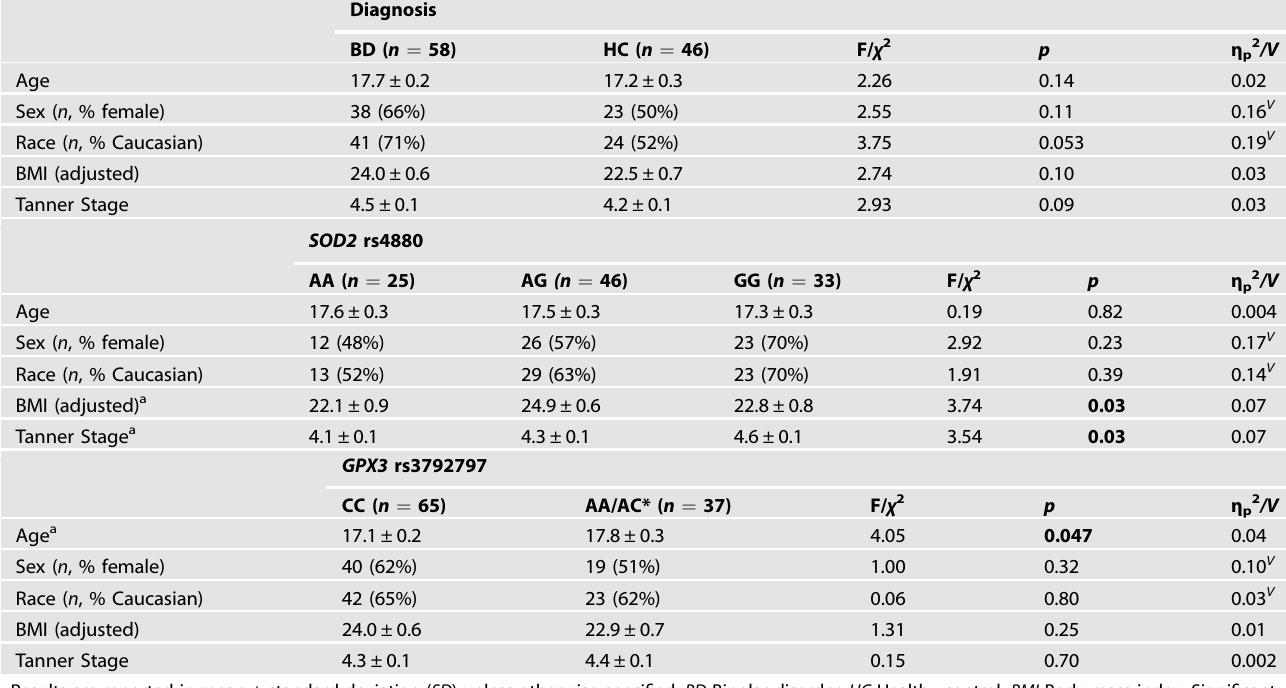
Table 2. Demographic Characteristics by Diagnosis and SNPs in two antioxidant enzyme genes.